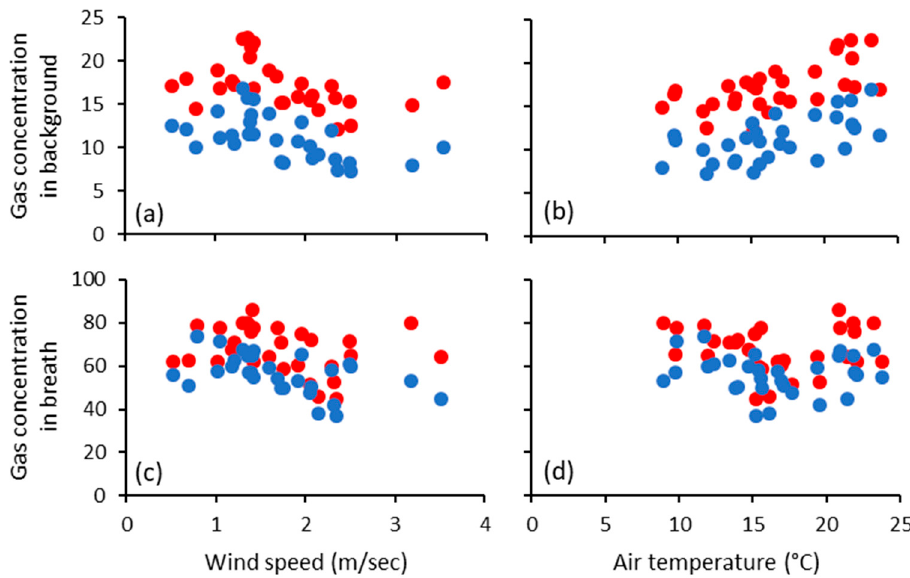
Figure 2. Concentrations of SF6 ( ● , ppt) and methane ( ● , ppm) in: background samples as influenced by ( a ) mean daily wind speed, and ( b ) mean daily air temperature; and in breath samples as influenced by ( c ) mean daily wind speed, and ( d ) mean daily air temperature. Note, each datum depicted is the mean of data from 40 individual cows.